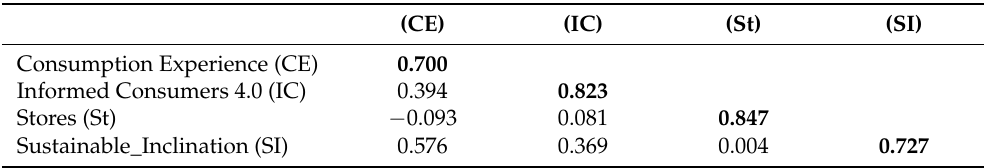
Table 5. Discriminant validity—Fornell–Larcker